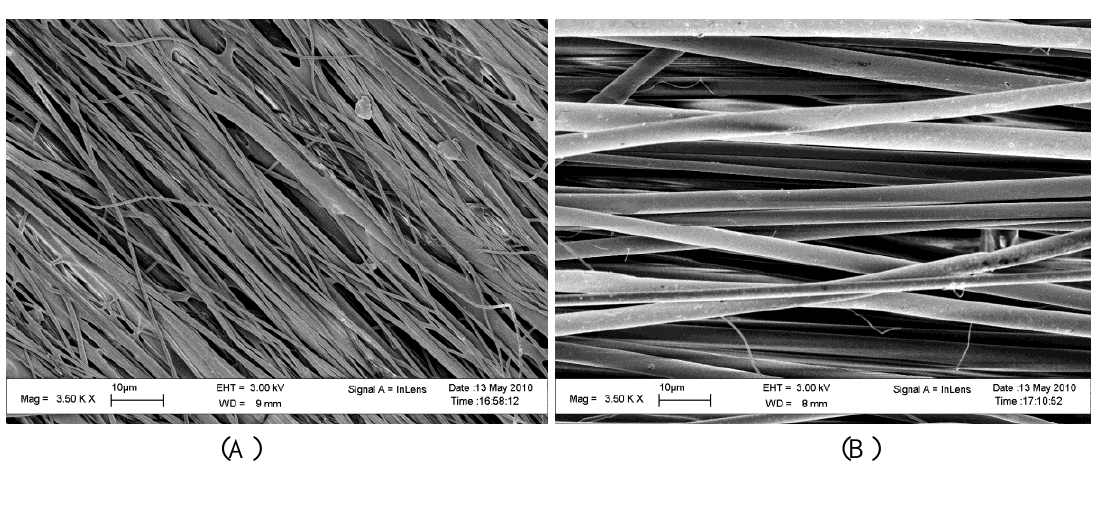
Figure 2. Scanning electron micrographs of aligned fibrous meshes having diameters at